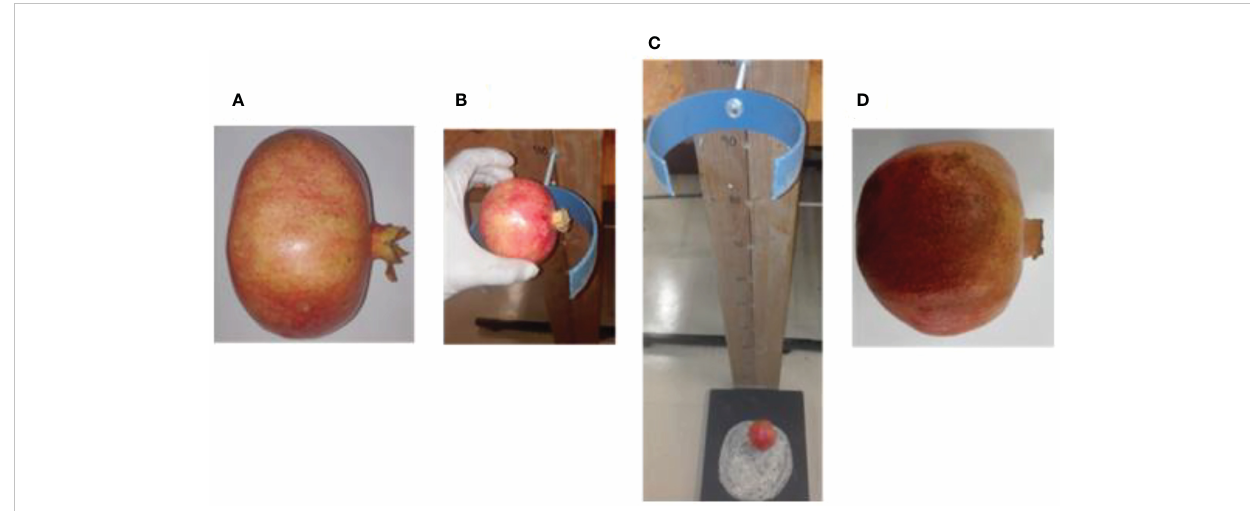
FIGURE 1 Picture of pomegranate fruit sample under drop impact bruise from 100cm height (A) fresh unbruised fruit sample (B) fruit placed at 100cm drop height (C) fruit dropped under free fall due to gravity (D) bruised fruit